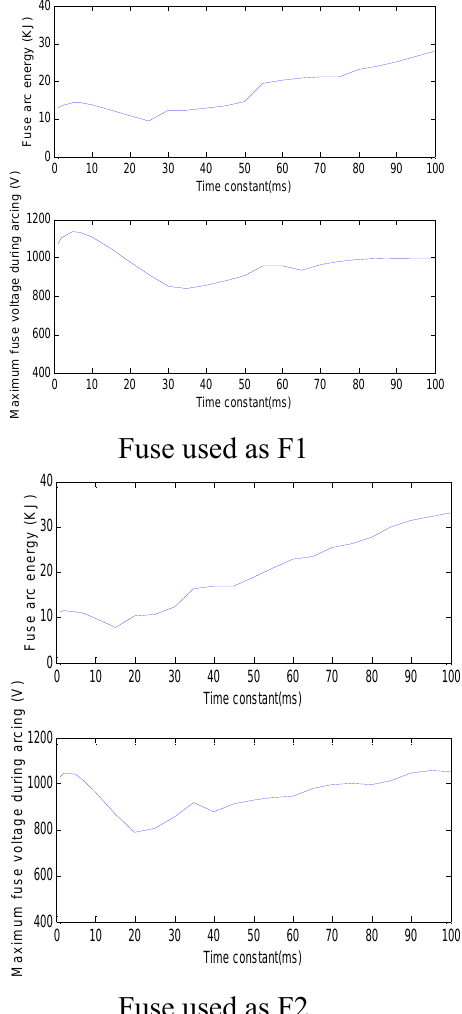
Figure 5. Variation of the arc energy (kJ) and peak fuse voltage (V) versus the DC machine time constant (ms) when the 200 A fuse used as F1 and